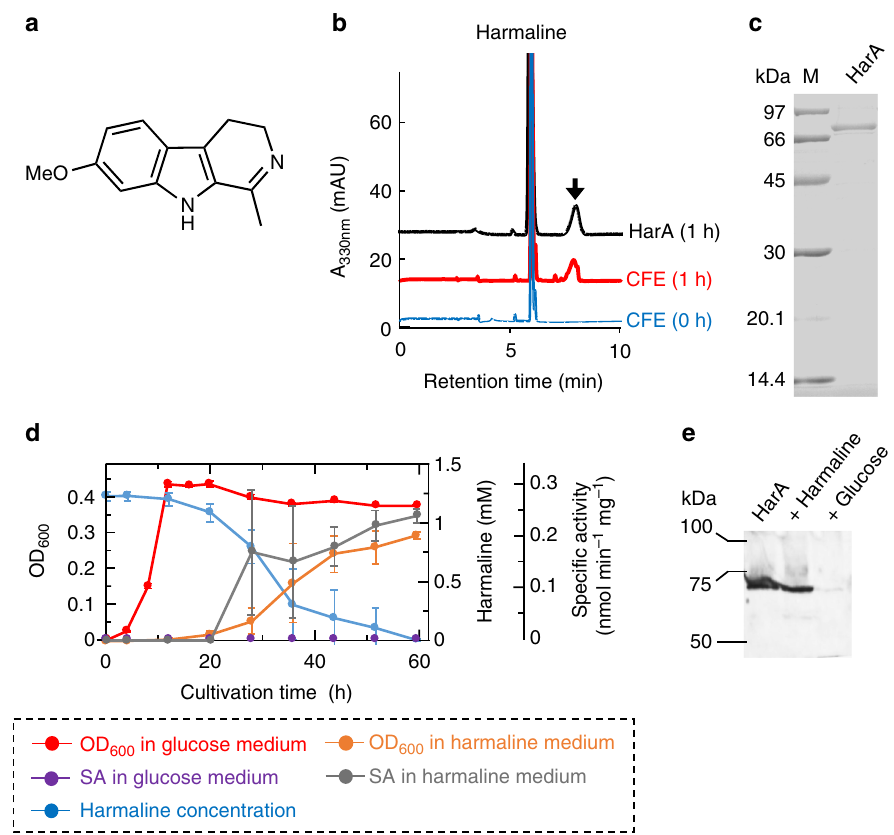
Fig. 1 Discovery of a harmaline-metabolizing enzyme. Harmaline-metabolizing enzyme HarA was found from strain C-4A. a Structure of harmaline. b LC/ MS analyses of the reaction product of harmaline. Reaction mixtures containing harmaline and each of a cell-free extract of strain C-4A and puri fi ed HarA were incubated and then analyzed at 330 nm. The arrow indicates the reaction product that exhibits m/z 230 [M − H] − in the negative ion mode. c SDS- PAGE of puri fi ed HarA. Lane M, marker proteins: phosphorylase b (97 kDa), bovine serum albumin (66kDa), ovalbumin (45 kDa), carbonic anhydrase (30 kDa), soybean trypsin inhibitor (20.1 kDa), and α -lactalbumin (14.4 kDa). The fi nal concentration and purity of HarA were 0.186 mg ml − 1 and